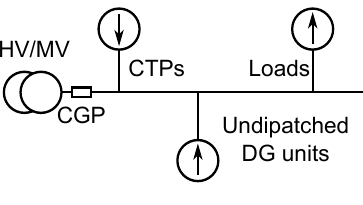
Figure 4. Measured feeder.